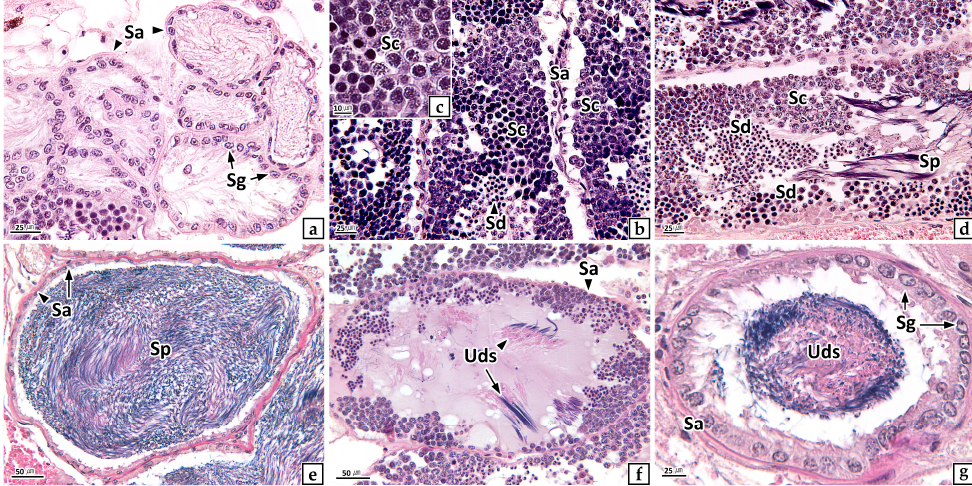
Figure 6. Testicular development stage of Buccinum osagawai . H–E stain. ( a ) spermatogonia (Sg) in inactive stage; ( b ) early active stage; ( c ) spermatocytes (Sc); ( d ) late active and mature stage; ( e ) sperm (Sp) in ripe stage; ( f , g ) spent and degenerative stage. Sa: spermatogenic acini; Sd: spermatids; Uds: undischarged